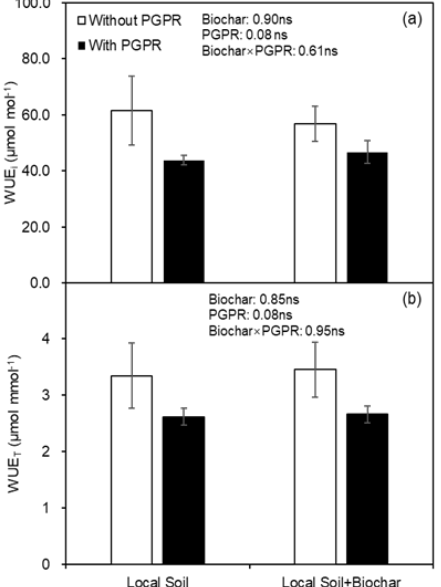
Figure 4. ( a ) Intrinsic water use efficiency (WUE i ) and ( b ) instantaneous water use efficiency (WUE T ) of potato leaf as affected by biochar amendment and PGPR inoculation at first harvest. ns indicates the effect was not statistically significant at p < 0.05